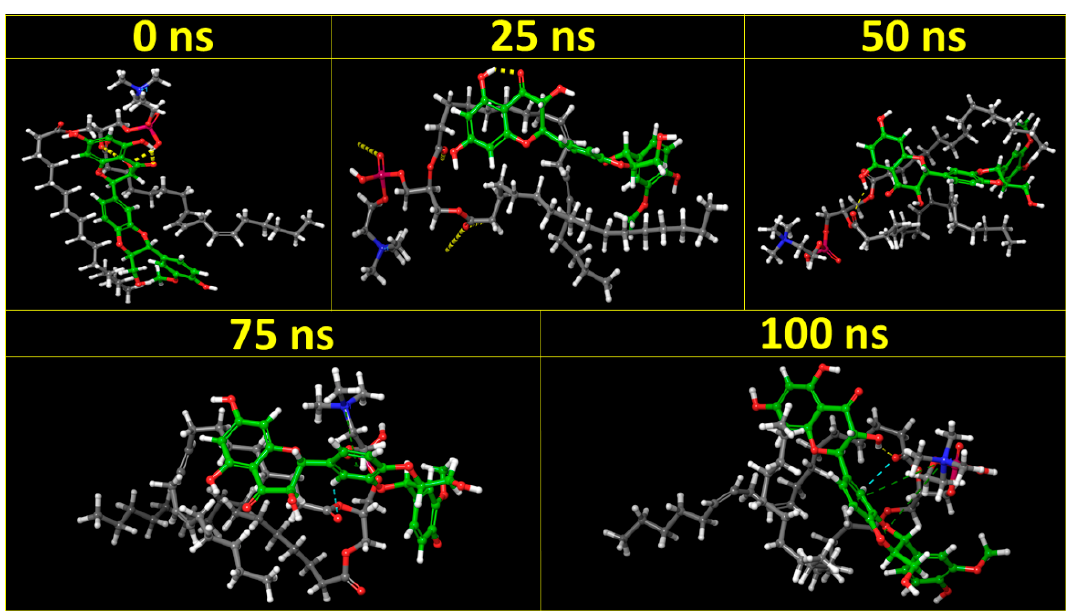
Figure 11. Molecular dynamic simulation of SIL–SPC complex at 0, 25, 50, 75 and 100 ns.